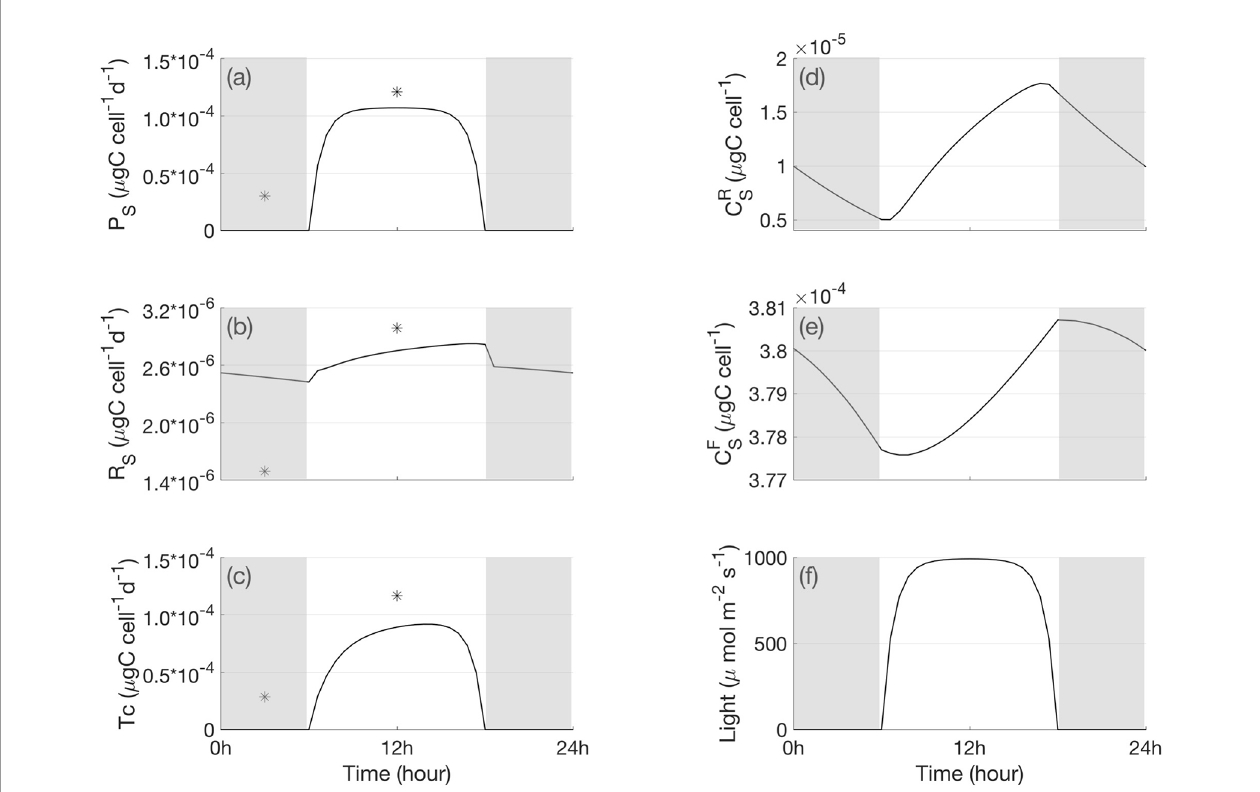
FIGURE 3 | A 24-h cycle of the simulated metabolic processes and carbon content in the symbiont cell (A) gross and net photosynthesis, (B) respiration, (C) translocation, (D) carbon in the symbiont reserve pool, (E) carbon in the symbiont functional pool, and (F) light condition. The star signs indicate the measured daily carbon fl ux in light- and shade- adapted condition in Muscatine et al. (1984). The shaded bars indicate bark